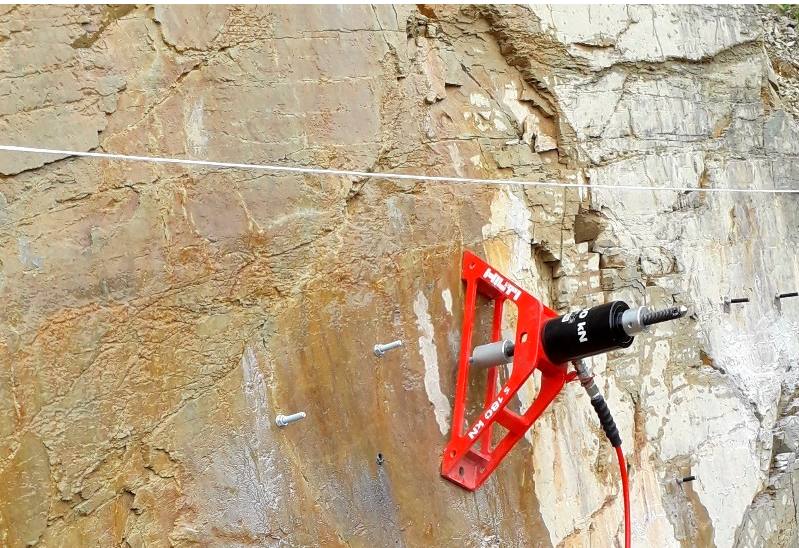
Figure 1. Test setup with hydraulic handpump, wide load bridge and scanline. Table 1. Overview of the conducted test program.